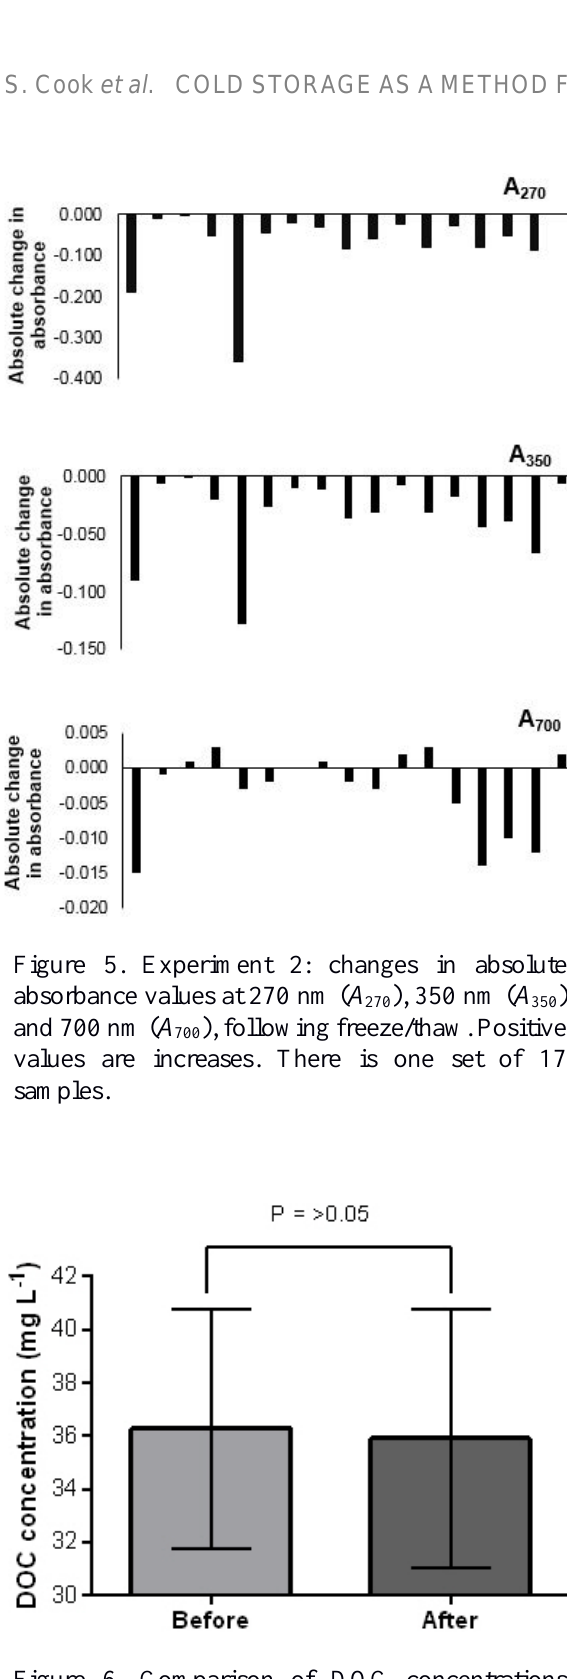
Figure 6. Comparison of DOC concentrations before and after freeze/thaw, in Experiment 2. DOC concentrations were calculated using the two-wavelength approach (Carter et al . 2012). Error bars show the standard error of the mean ( n =